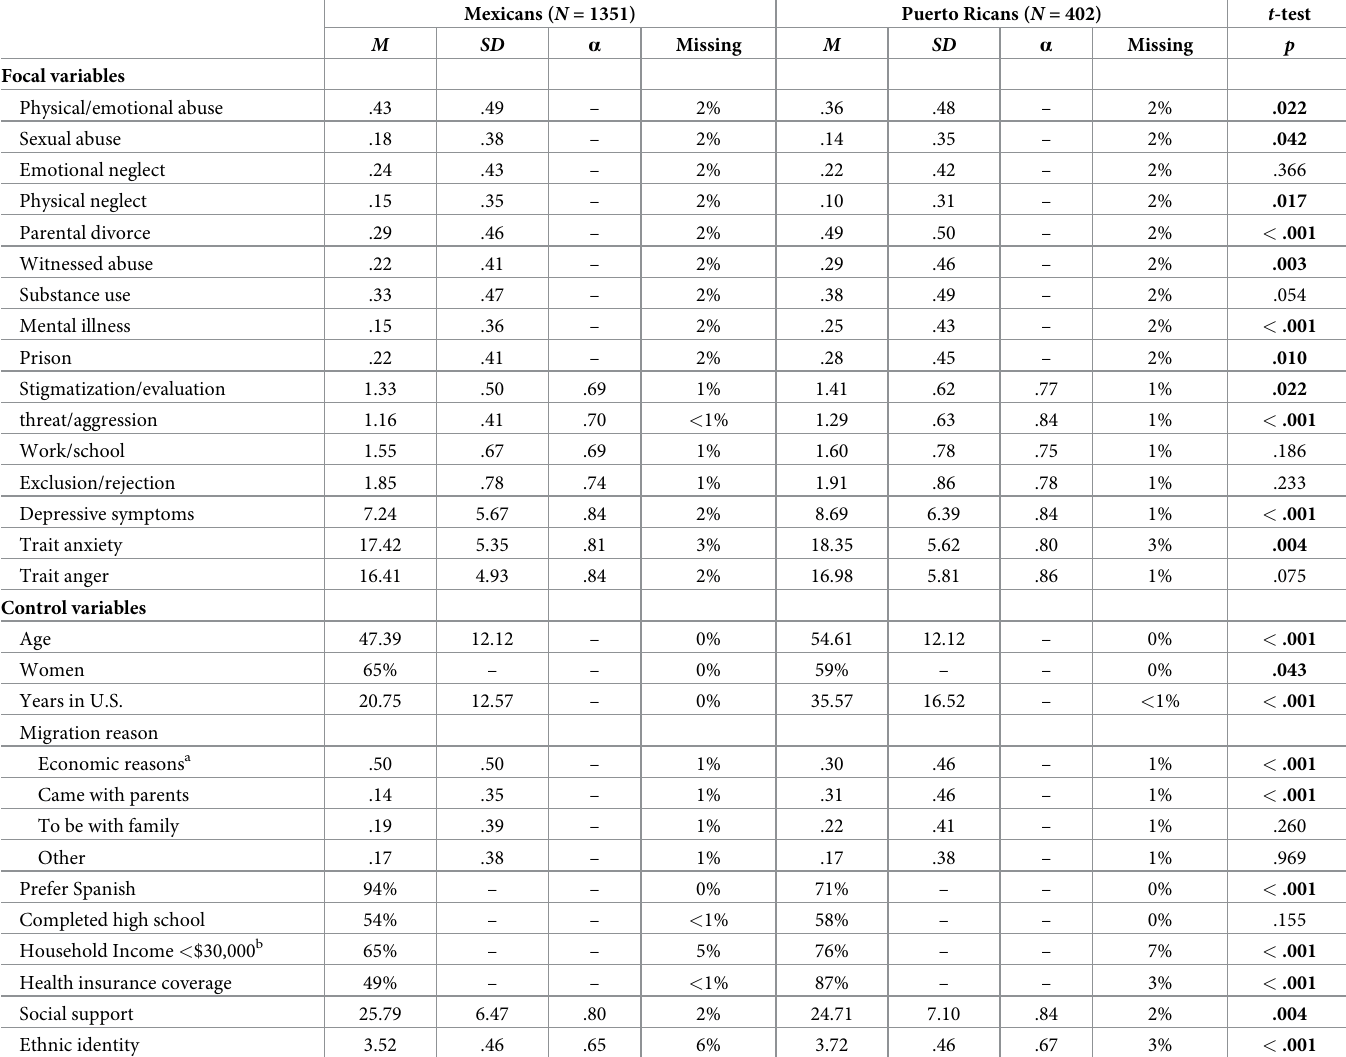
Table 1. Descriptive statistics of study variables for Mexicans and Puerto